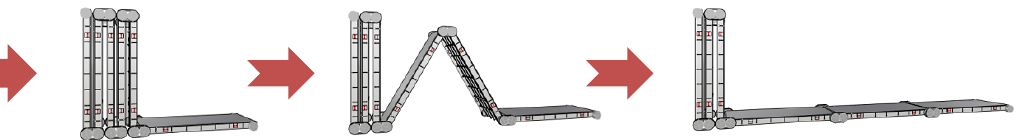
Figure 7. The deployment process of the floating bridge.